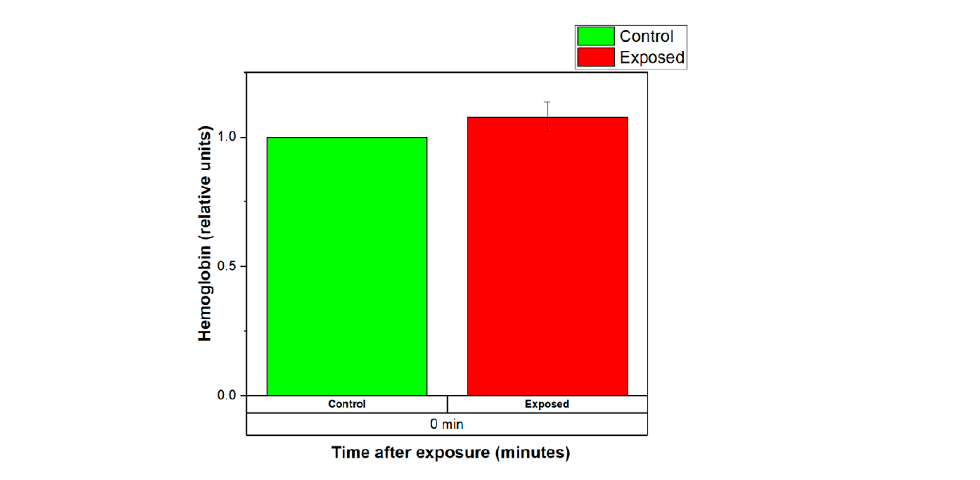
Figure 12. Normalized levels of the hemoglobin released by the control (sham-exposed) and exposed erythrocyte suspensions for 120 min to 2.41 GHz (WSA SAR = 29.6325 W/kg, psSAR1g = 41.13 W/kg, wearable antenna input power 450 mW, Zigbee-like signal). The mean of 4 experiments ± SEM is shown.